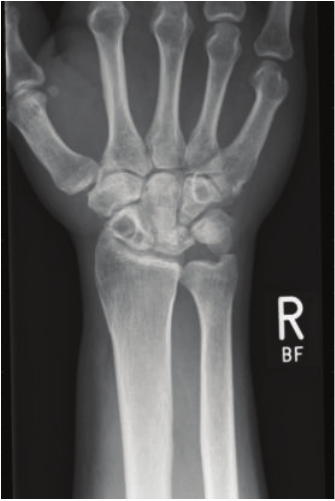
Figure1:X-Ray:cysticscaphoidchangesandpartiallunatecollapse.